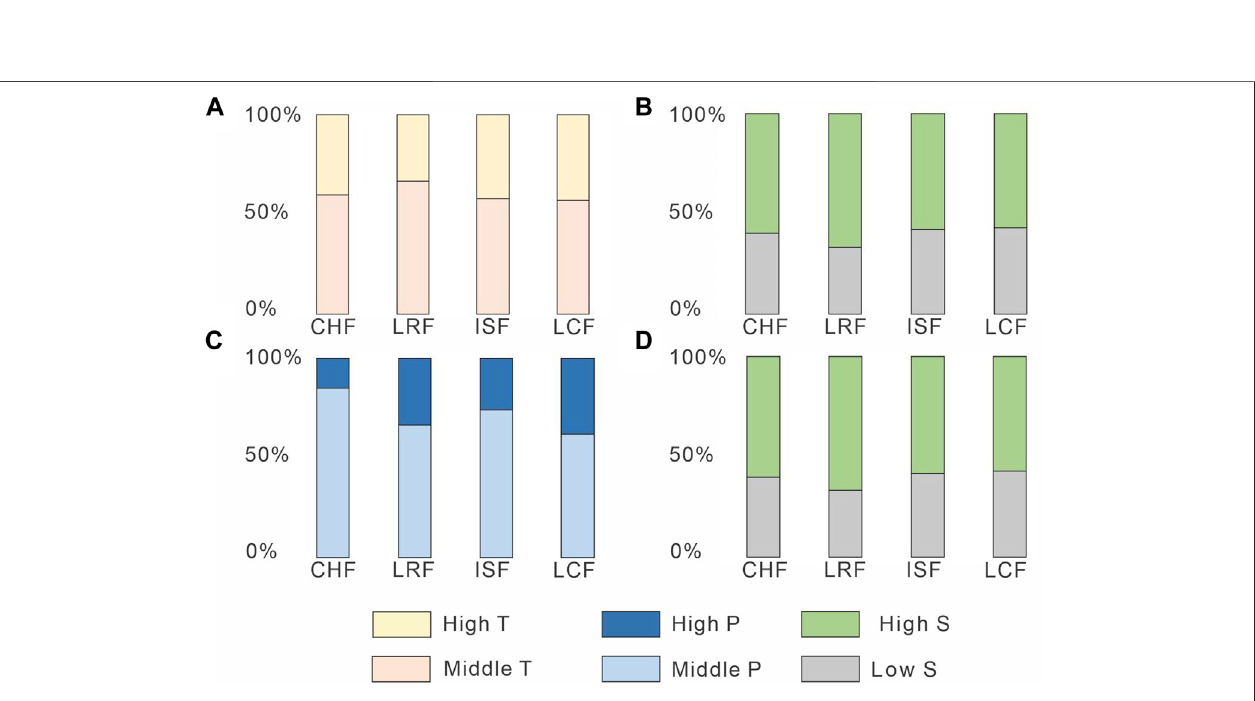
Frontiers in Earth Science |